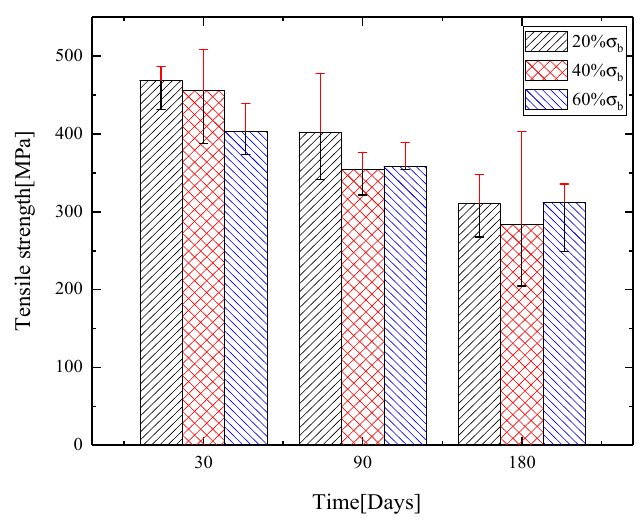
Figure 4. Tensile strength and standard deviation of GFRP bars.